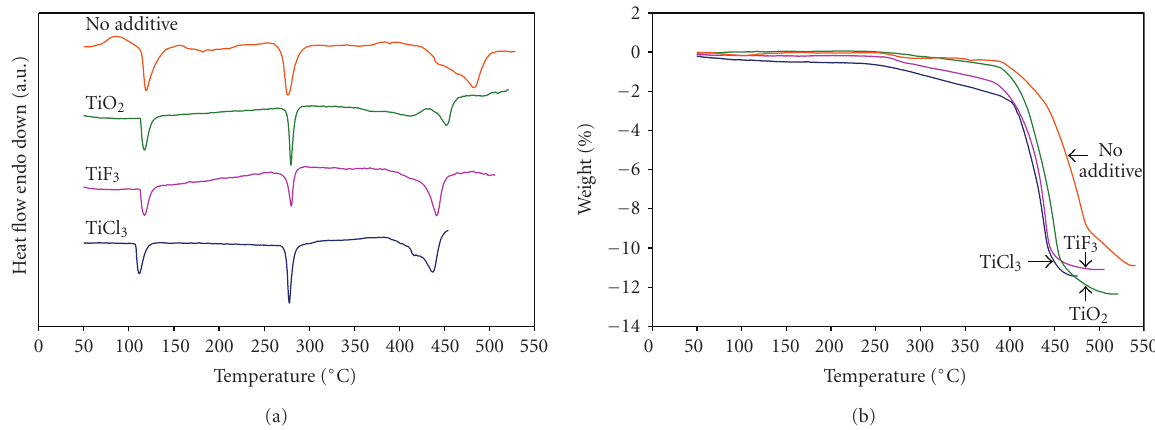
Figure 1: (a) DTA and (b) TGA curves of the LiBH 4 /CaH 2 mixture without additives and with 4mol% of various additives.